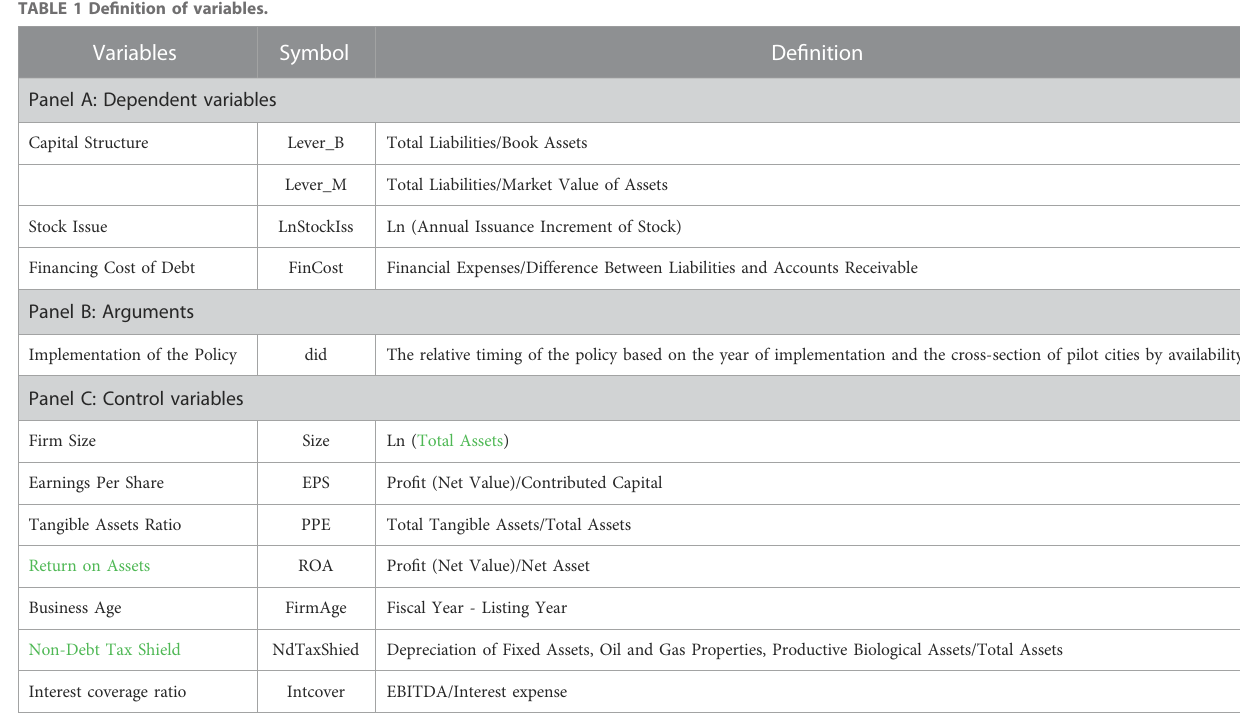
TABLE 1 De fi nition of variables.